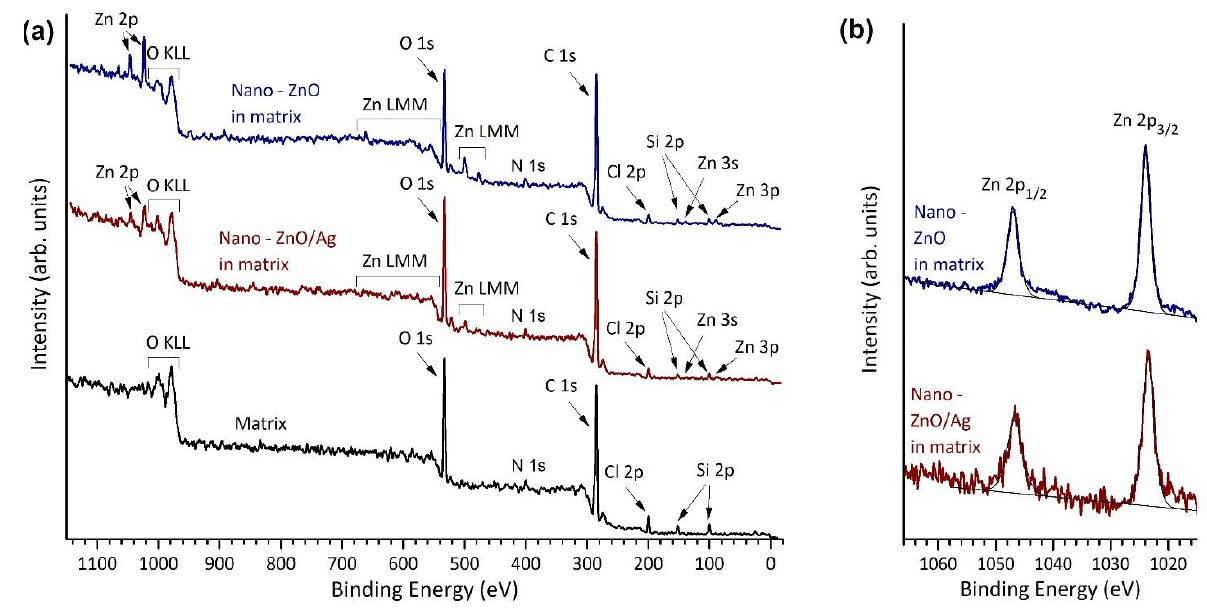
Figure 3. ( a ) XPS overview spectra (hv = 1486.6 eV, scan step 0.5 eV) and ( b ) Zn 2p XPS spectra (hv = 1486.6 eV, scan step 0.1 eV) of nano-ZnO- and nano-ZnO/Ag-containing coatings and pure matrix material on plywood substrates. According to the Zn 2p photoline positions and shape, Zn is in 2+-oxidation state. Table 1. Atomic concentration of elements in nano-ZnO- and nano-ZnO/Ag-containing coatings and in pure matrix ma- terial on plywood substrates according to XPS analysis.